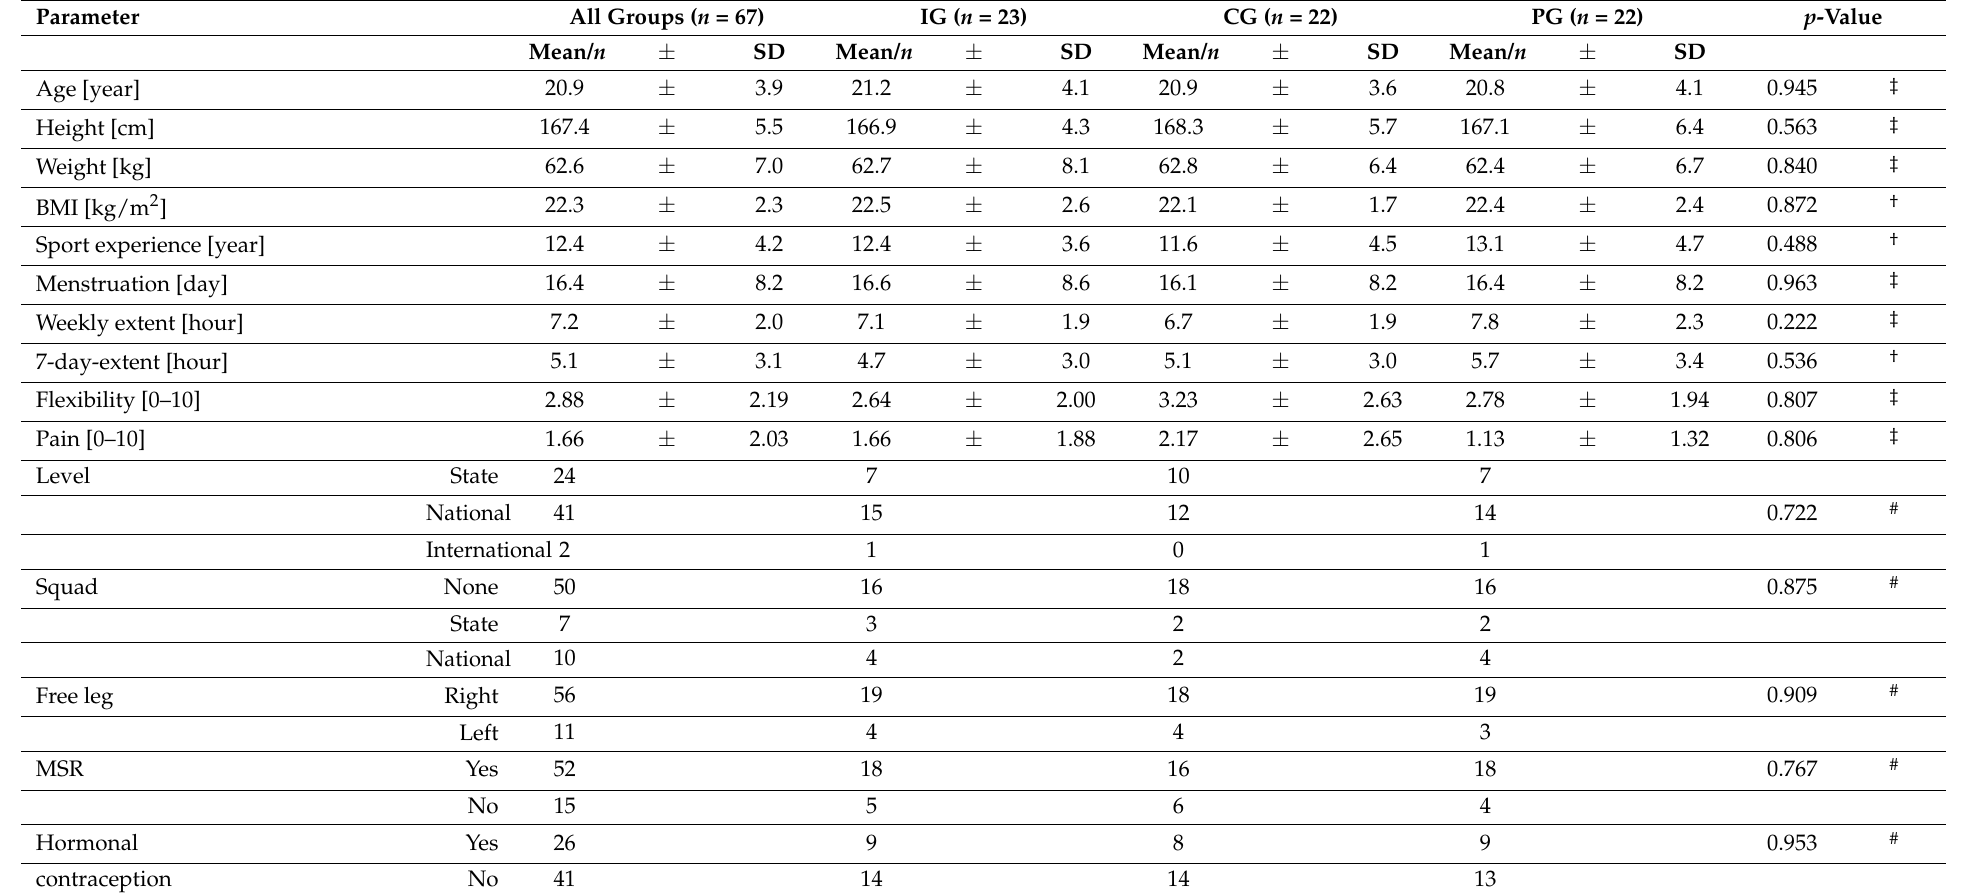
Table 1. Quantitative and qualitative baseline